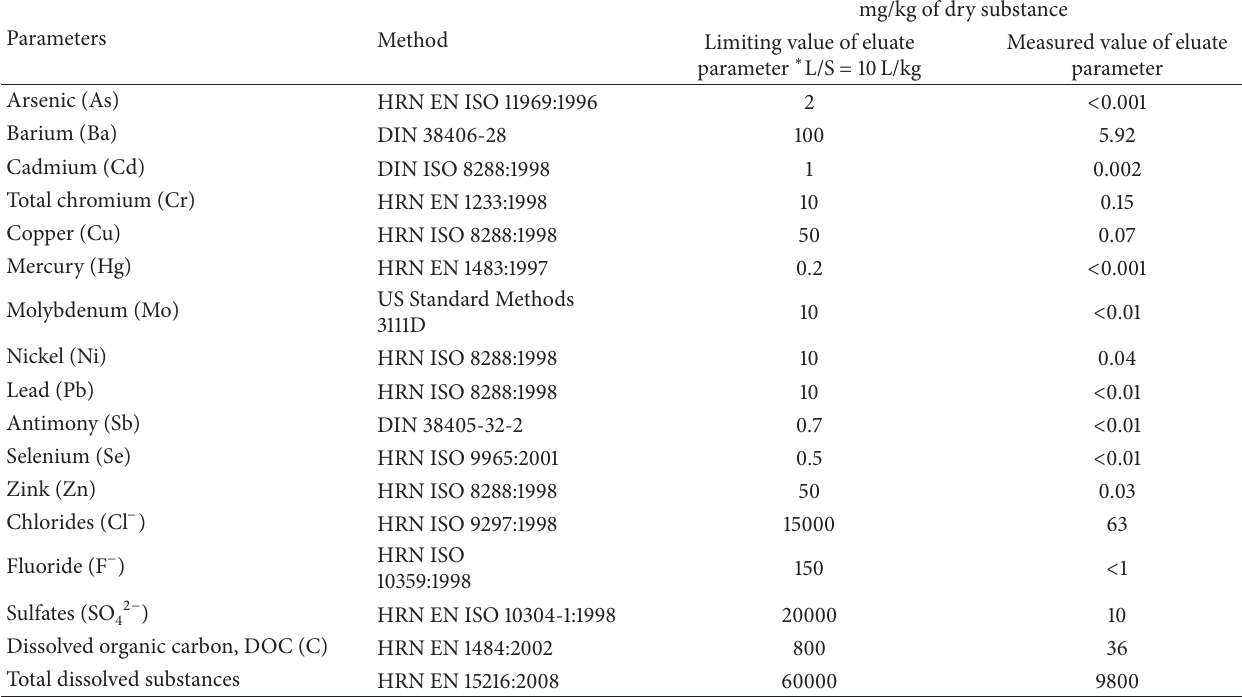
Table 2: Results of measuring parameter values of the LF